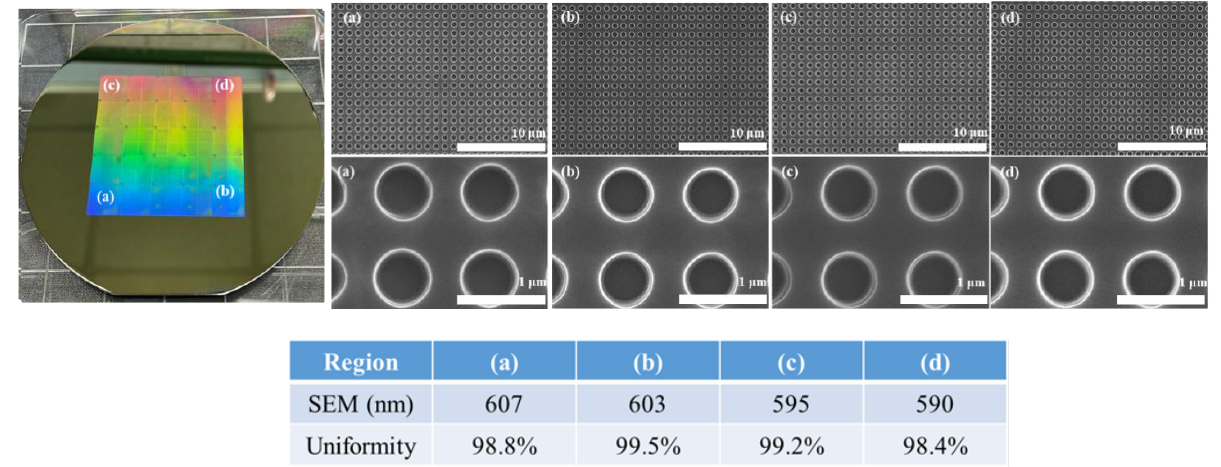
Figure 5. Results of the step-and-repeat NIL on the 4-inch silicon wafer and the diameter uniformity of the hole pattern in the same four regions after the step-and-repeat NIL.